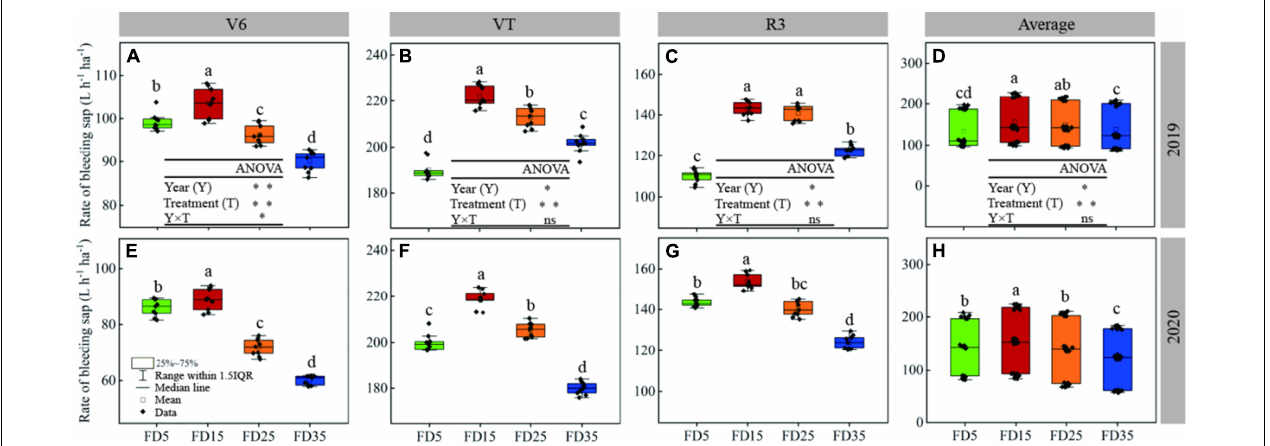
FIGURE 5 | Effects of fertilizer application depths on rate of root bleeding sap at V6, VT, and R3 stages of summer maize in 2019 (A–C) and 2020 (E–G) ; Effects of fertilizer application depths on the average rate of root bleeding sap of the whole summer maize growing season in 2019 (D) and 2020 (H) . FD5, fertilizer application at a depth of 5 cm; FD15, fertilizer application at a depth of 15 cm; FD25, fertilizer application at a depth of 25 cm; and FD35, fertilizer application at a depth of 35 cm. The different lowercase letters indicate a significant difference among the treatments at P < 0.05 using the LSD method. ns, no significant difference; ∗ , significant at P < 0.05; ∗∗ , significant at P < 0.01.